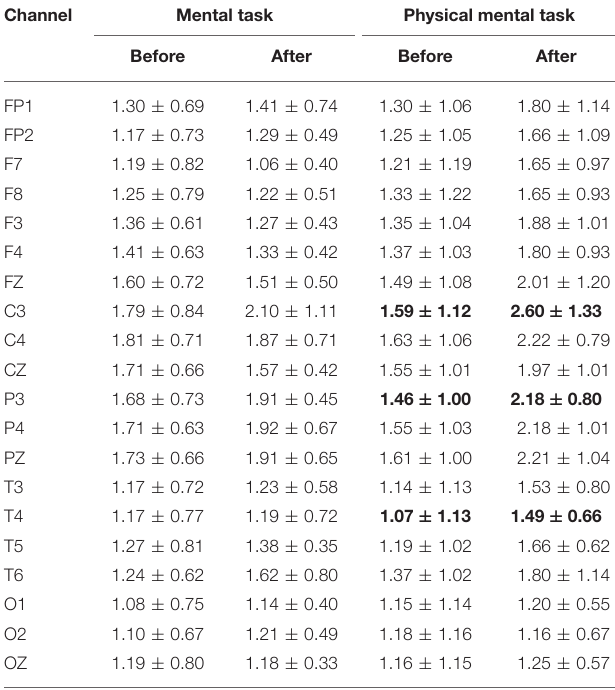
TABLE 3 | E α /β for mental and physical mental tasks. Channel